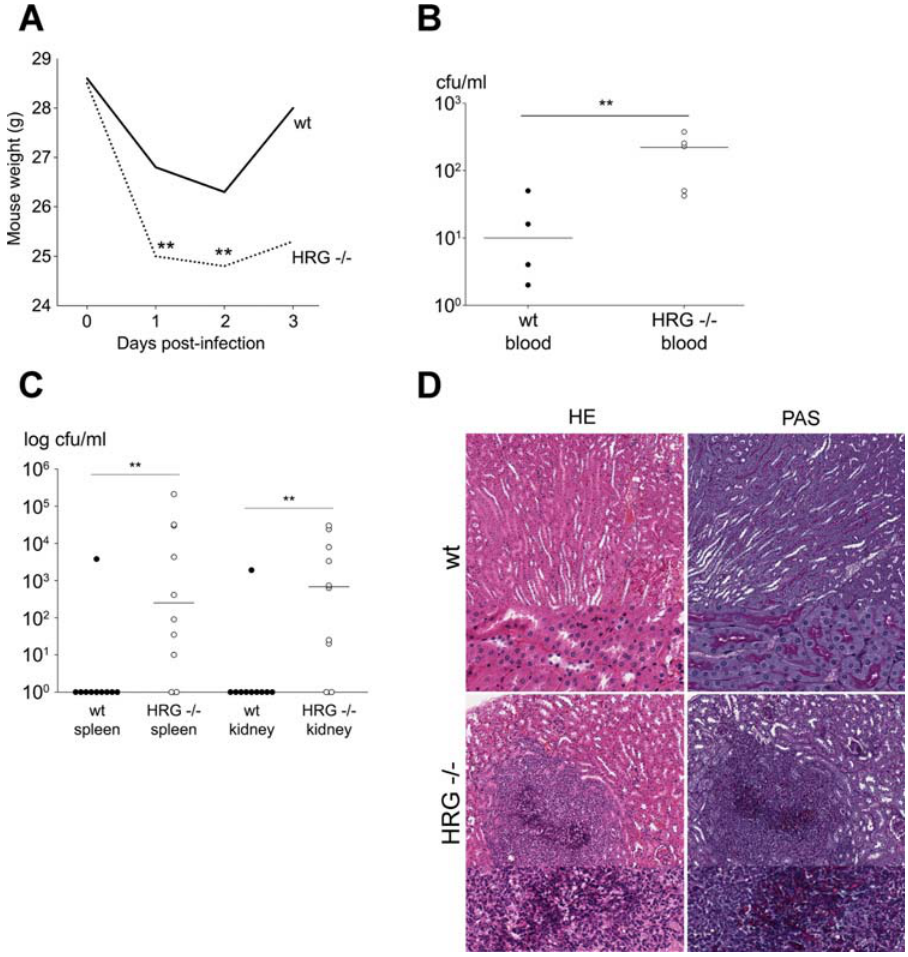
Figure 6. Candida produces severe infection in Hrg 2 / 2 mice. ( A ) Weight loss in mice after infection with C.albicans . C57BL/6 (solid line) and C57BL/6 Hrg 2 / 2 (dotted line) mice were infected (i.p.) with 1 6 10 9 cfu of C. albicans , and the body weight was followed from day 0 to day 3 (n=6,4 and 2, respectively) (p=0.02). ( B ) Fungal dissemination to the bloodstream. C57BL/6 ( N ) (n=4) and C57BL/6 Hrg 2 / 2 ( # ) (n=5) mice were infected as above and the animals were sacrificed on day 2 and number of cfu in blood was determined (p=0.032). ( C ) HRG suppresses fungal dissemination to the spleen and kidney. C57BL/6 ( N ) and C57BL/6 Hrg 2 / 2 ( # ) mice were infected as above and the cfu of C. parapsilosis in spleen and kidney was determined (p=0.009, n=10) ( D ) In two animals kidneys were collected on day 3, fixed, sectioned and then stained with hematoxylin and eosin (HE) (left panel) or PAS (right panel) (upper section; magnification 6 10 and lower section; magnification 6 30).